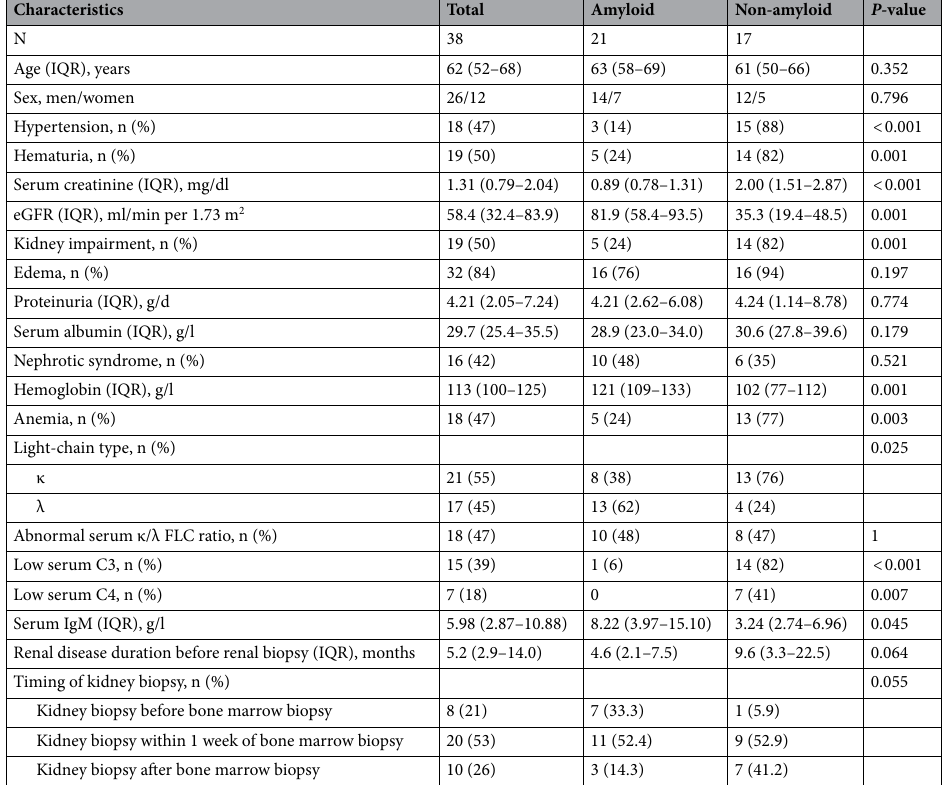
Table 1. Demographics and characteristics at kidney biopsy of patients with MGRS with IgM Monoclonal